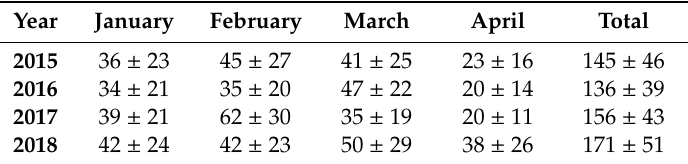
Table 4. Estimated total monthly ER visits due to asthma in Georgia. The uncertainties were derived from Equation 2 assuming 50% uncertainty in β (the health e ff ect estimate from the epidemiological study) and 40% uncertainty in ∆ PM (the change in air pollutant concentration).